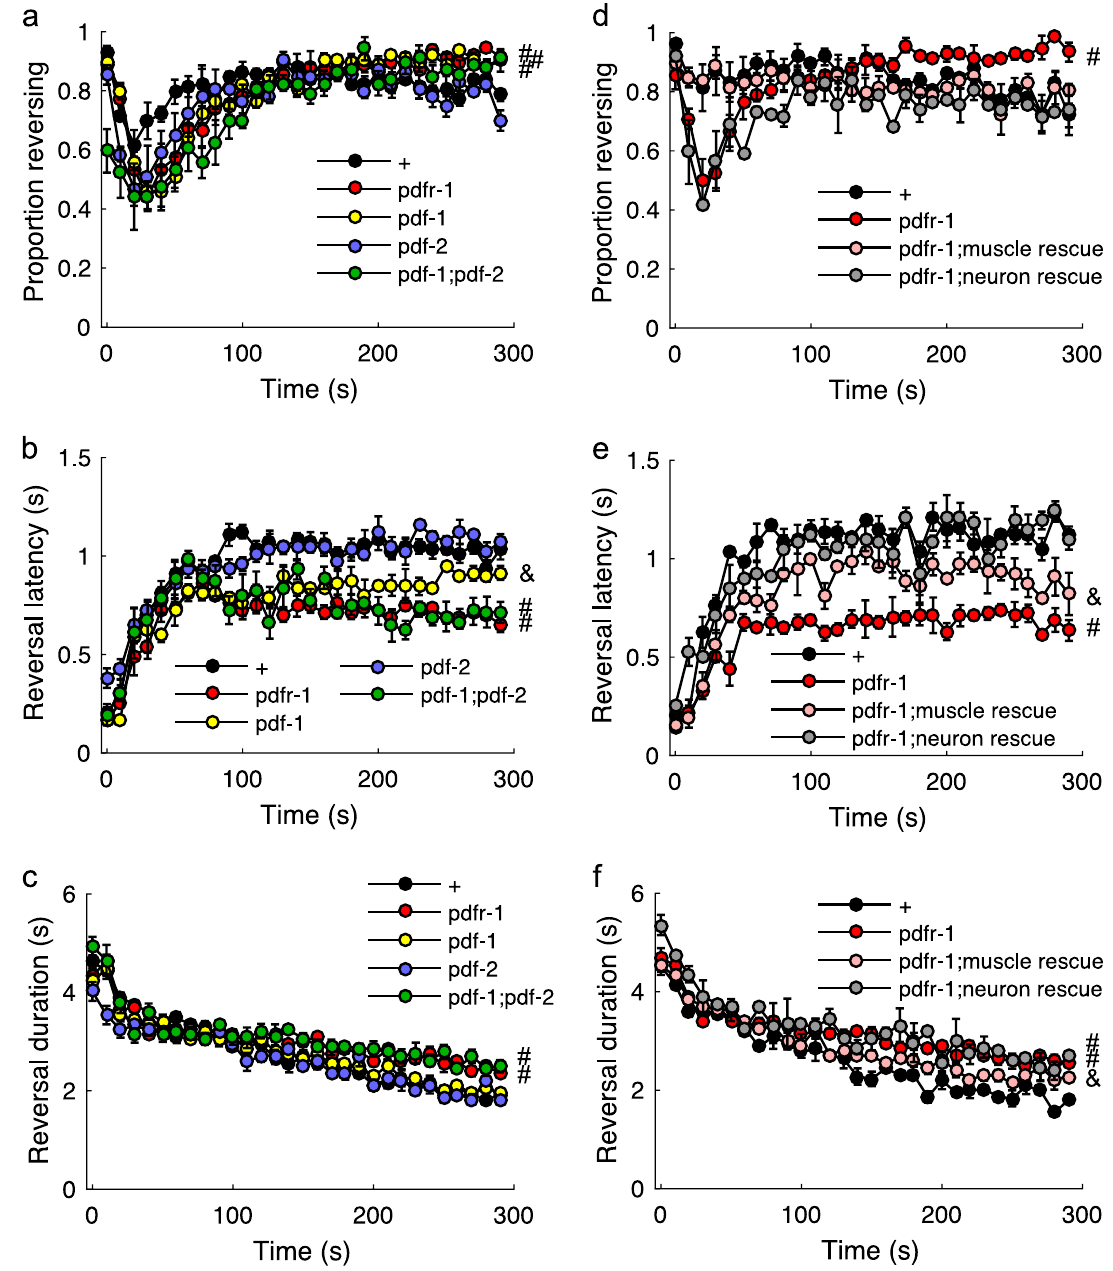
Fig. 3 PDF signaling promotes habituation. Proportion of the population reversing ( a ), reaction time ( b ), and response duration ( c ) to each of thirty 2 s light pulses administered at 0.1 Hz. d – f Effects of restoring PDFR-1 expression to neurons or muscles. Mean ± SEM. ‘ # ’ denotes groups signi fi cantly different from control and ‘ & ’ denotes groups signi fi cantly different from both control and the pdfr-1 mutant based on the response to the fi nal stimulus. N = 2 – 4